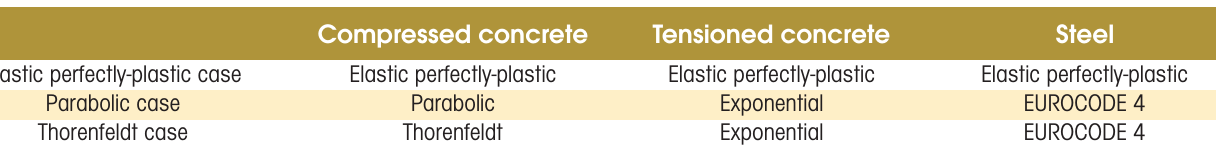
Table 2 – Combination of the constitutive models in the analyzed cases